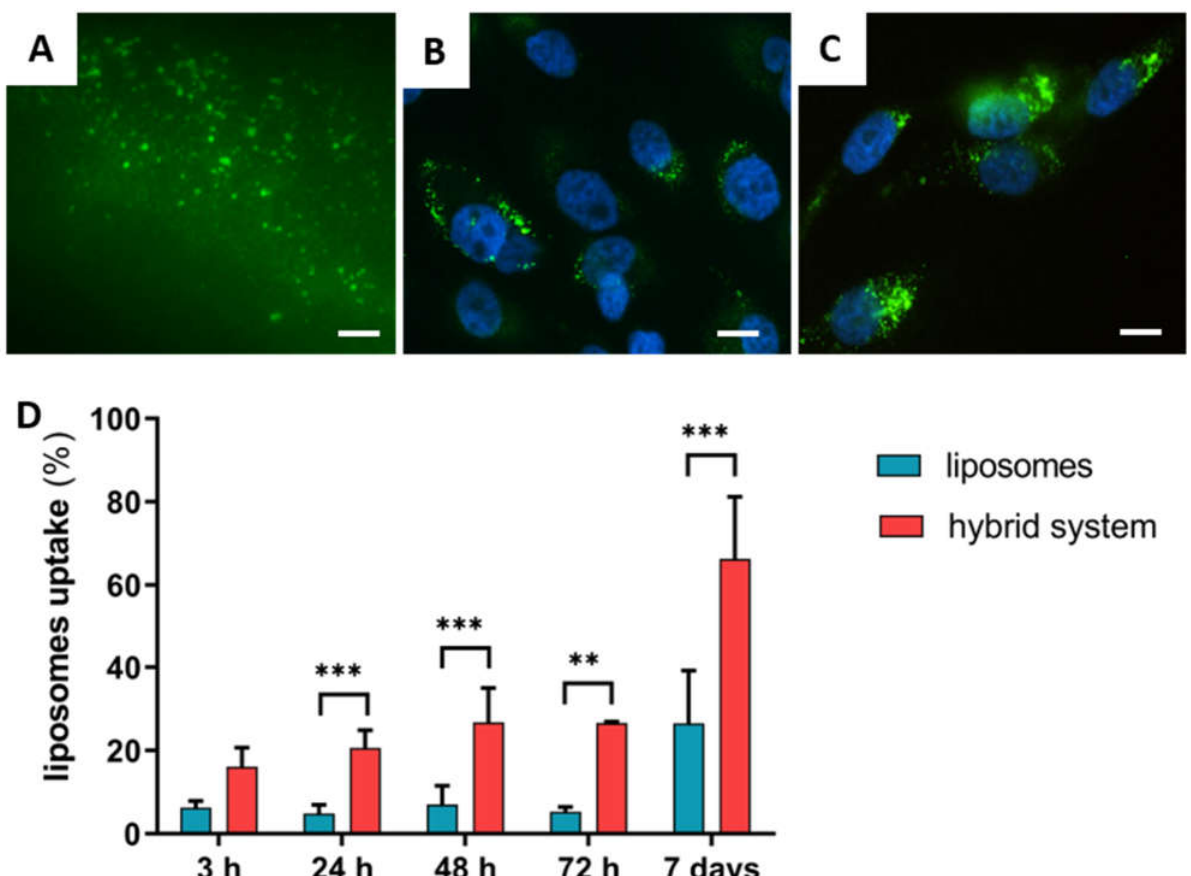
Figure 3. Fluorescence microscopy analyses of hybrid hydrogels based on fluorophore-labeled (TopFluor ® Lyso PC) liposomes after 24 h with cell media ( A ). Fluorescence microscopy analyses of MG63 cells after 24 h of incubation with liposomes ( B ) and with the hybrid system ( C ). The scale bar stands for 50 µ m (in ( A )) and 20 µ m (in ( B , C )). Lipid uptake from MG63 cells at different time points, i.e., 3 h, 24 h, 48 h, 72 h, and 7 days ( D ). Spectrofluorimetric analyses were performed to assess the internalization of fluorophore-labeled (TopFluor ® PC) liposomes. ** p -value < 0.01; *** p -value < 0.001.